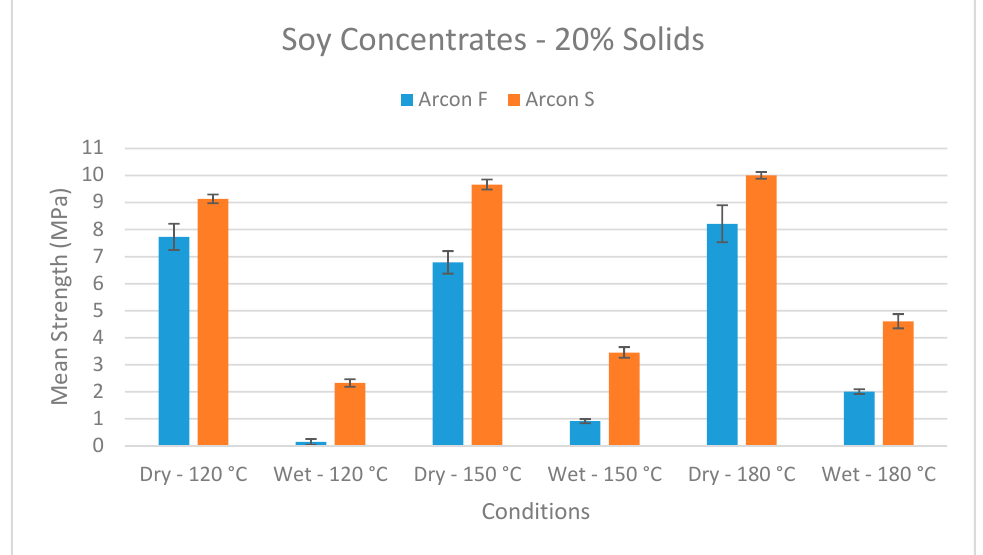
Figure 2. Wet shear strengths of soy concentrate adhesive with maple veneer bonded at different temperatures.